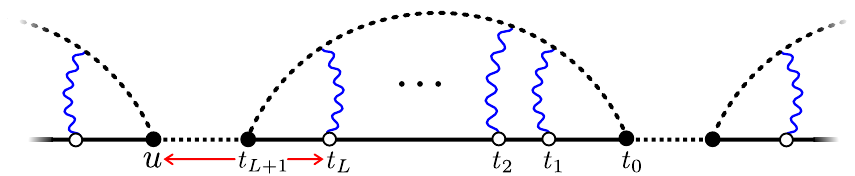
Figure 13 . One segment of the L -ladder fermion-antifermion pair insertion. Once integrating the last endpoint t , we arrive at the same integrand as for the line operators in the bosonic theory L +1 with α = 1 − 2 b